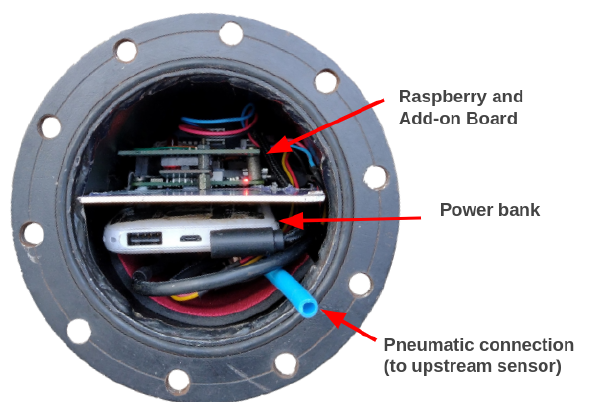
Figure 36. Rear-view of the PIG with the embedded system installed inside.